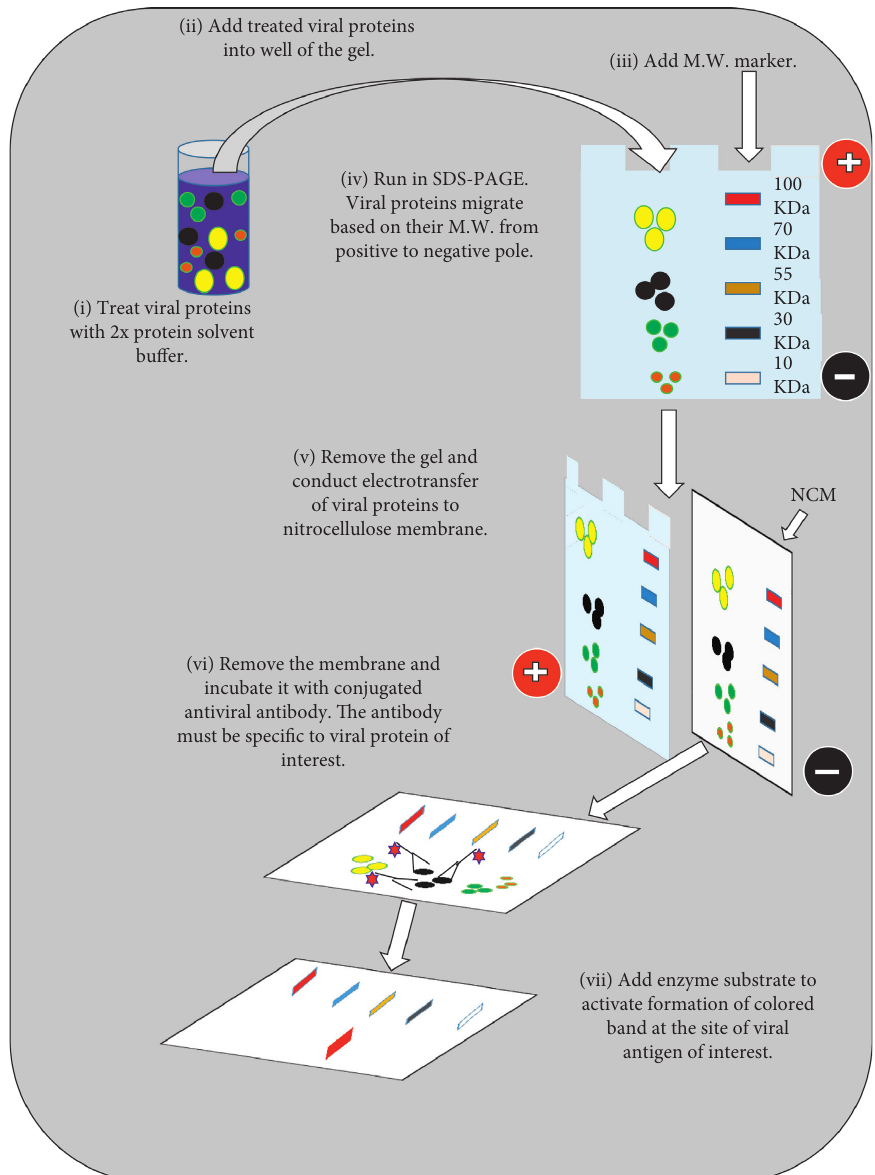
Figure 5: Schematic of immunoblot analysis of viral protein. Abbreviations: M.W., molecular weight; SDS-PAGE, sodium dodecyl sulfate- polyacrylamide gel electrophoresis; NCM, nitrocellulose